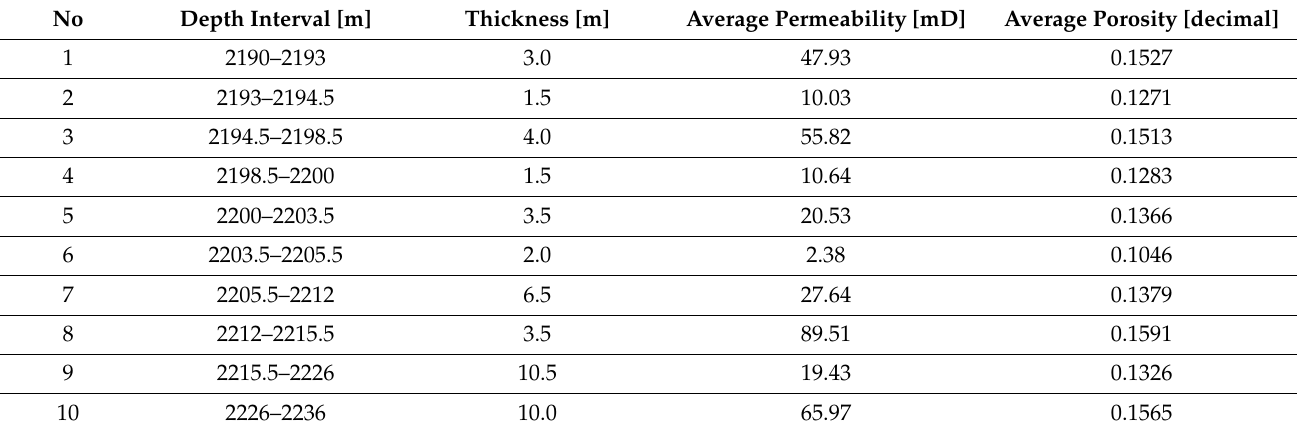
Table 3. Characteristics of the ten separate reservoir layers within the Drzewice (= Komorowo) Lower Jurassic Formation of the Sierpc structure in the Sierpc 2 well.